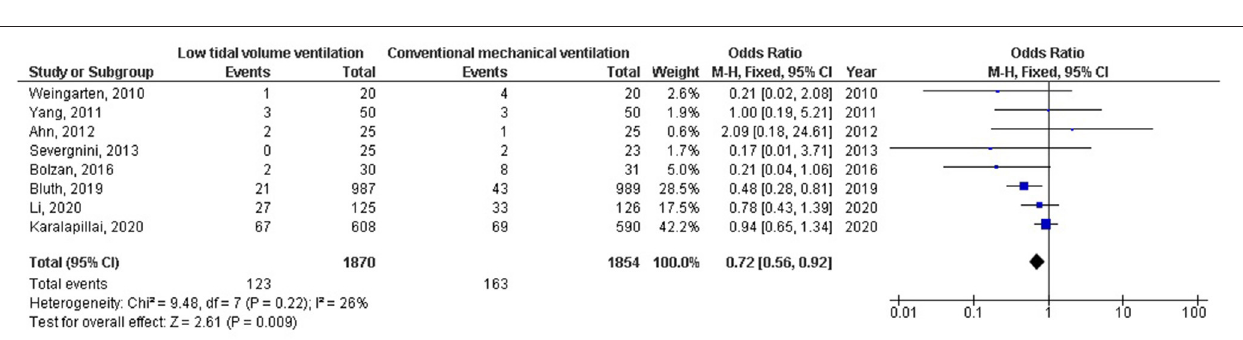
FIGURE 8 | Forest plot of the low tidal volumes strategy vs. conventional mechanical ventilation in subjects undergoing surgery on pneumothorax.